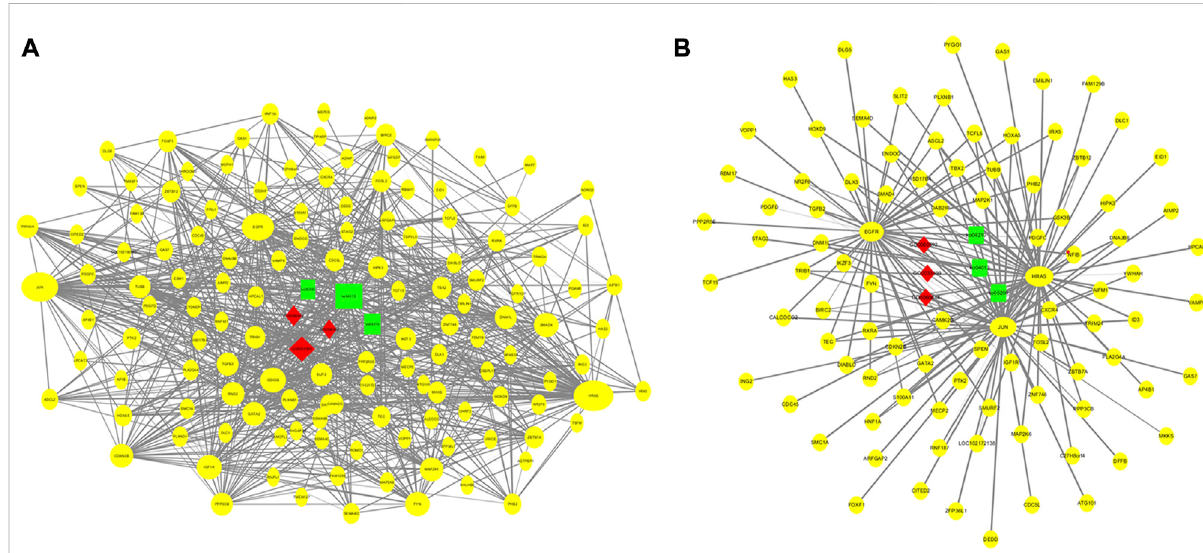
FIGURE 7 Regulation networks related to mammary gland development and lactation of dairy goats. (A) Interaction networks of 150 coexpressed genes. (B) Regulation networks of core gene